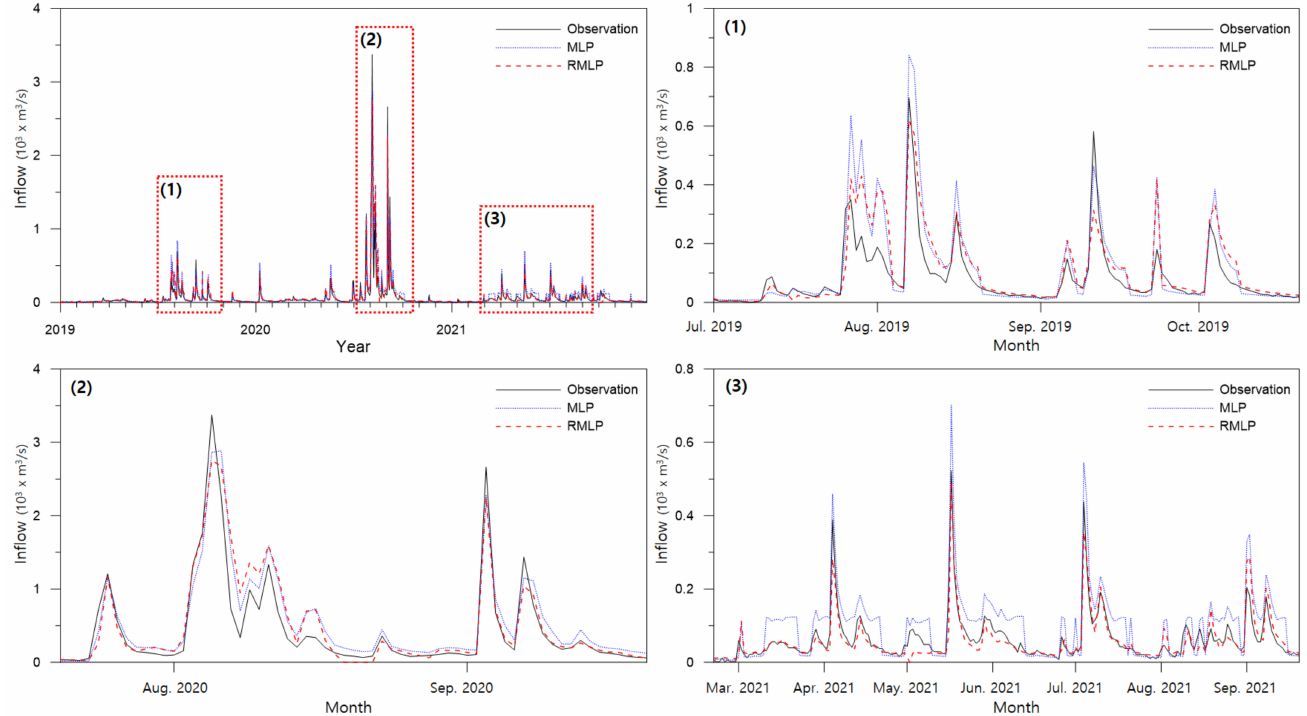
Figure 10. Model inflow prediction